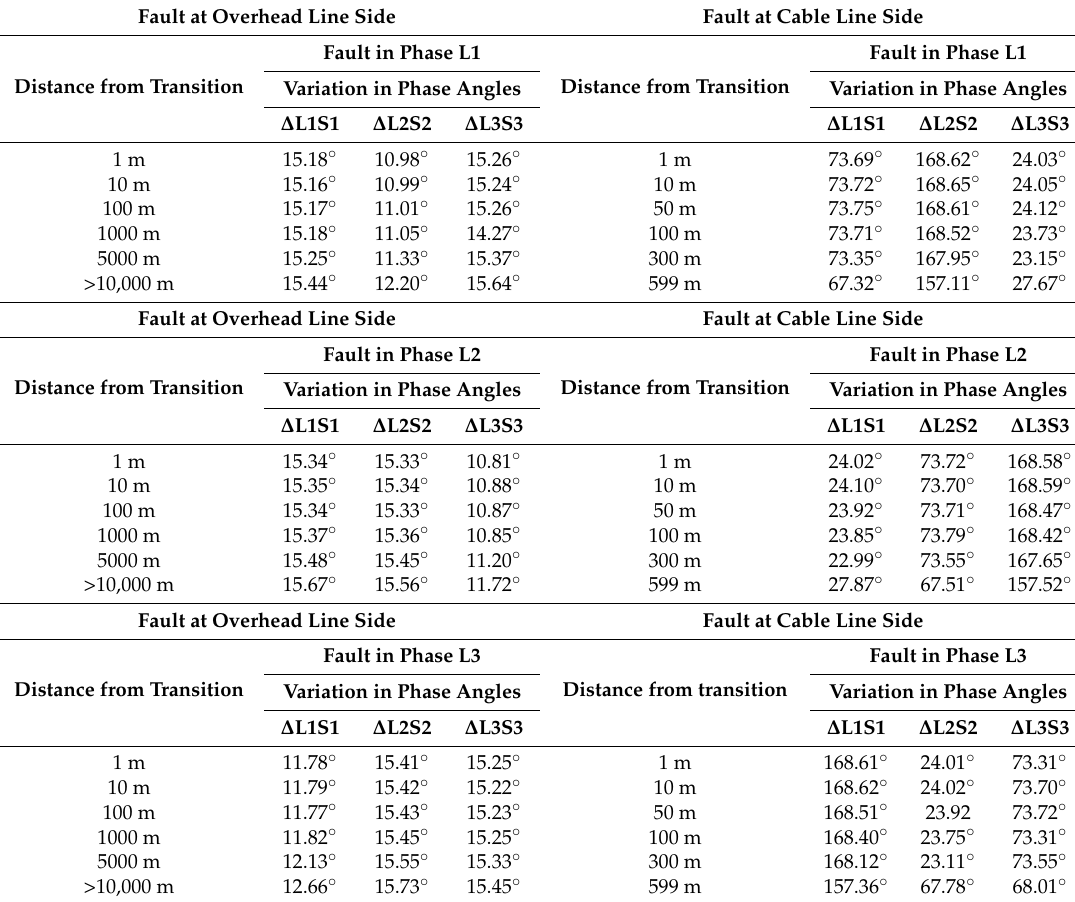
Table 1. Phase angle variation with ground faults at the overhead and cable line sides.